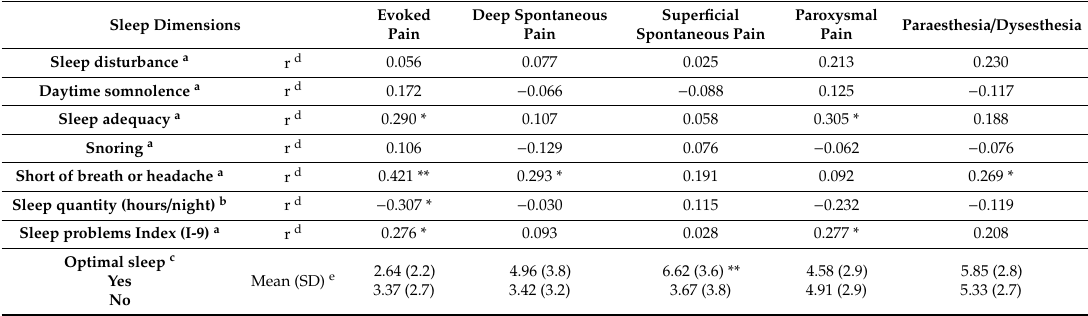
Table 3. Correlation between MOS sleep dimensions scores and Neuropathic Pain Symptom (NPSI) dimensions in DNP